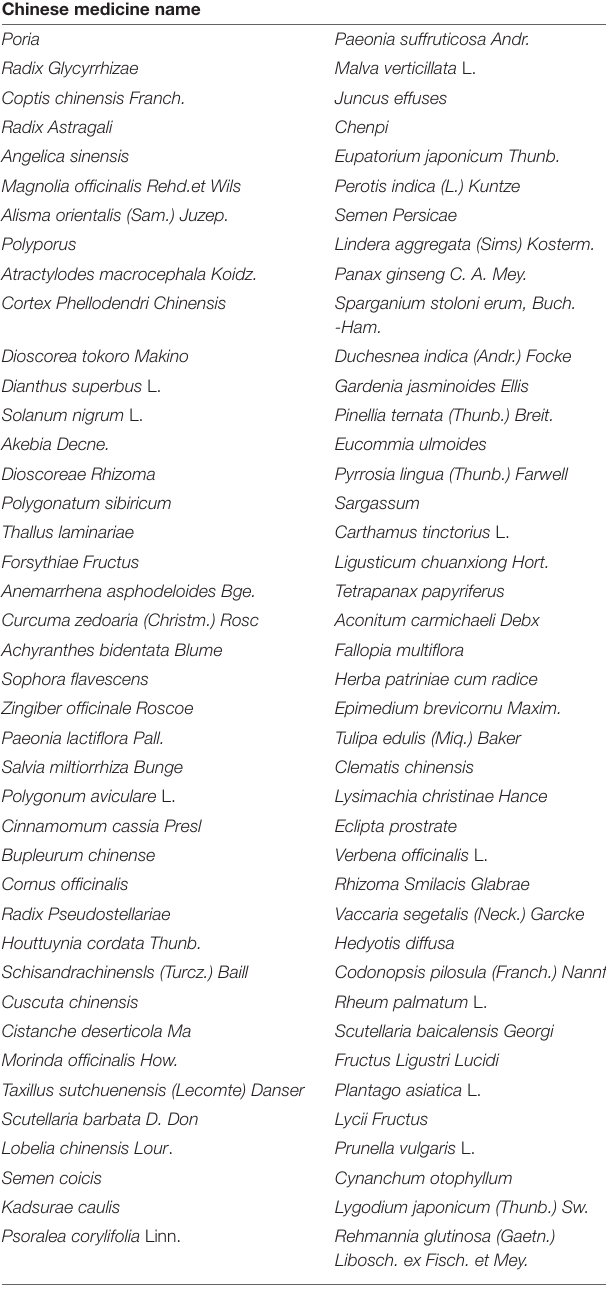
TABLE 1 | Chinese medicine with frequency ≥ 10 in anti-prostate cancer